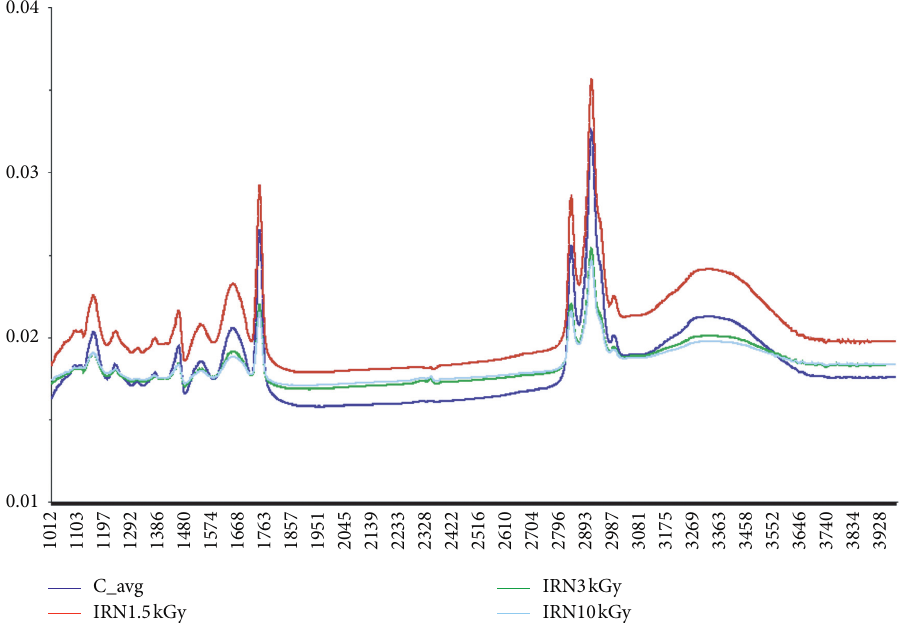
Figure 1: The average FTIR spectra of 1.5kGy, 3 kGy, and 10 kGy irradiated and control hazelnut samples in the 4000–1000cm − 1